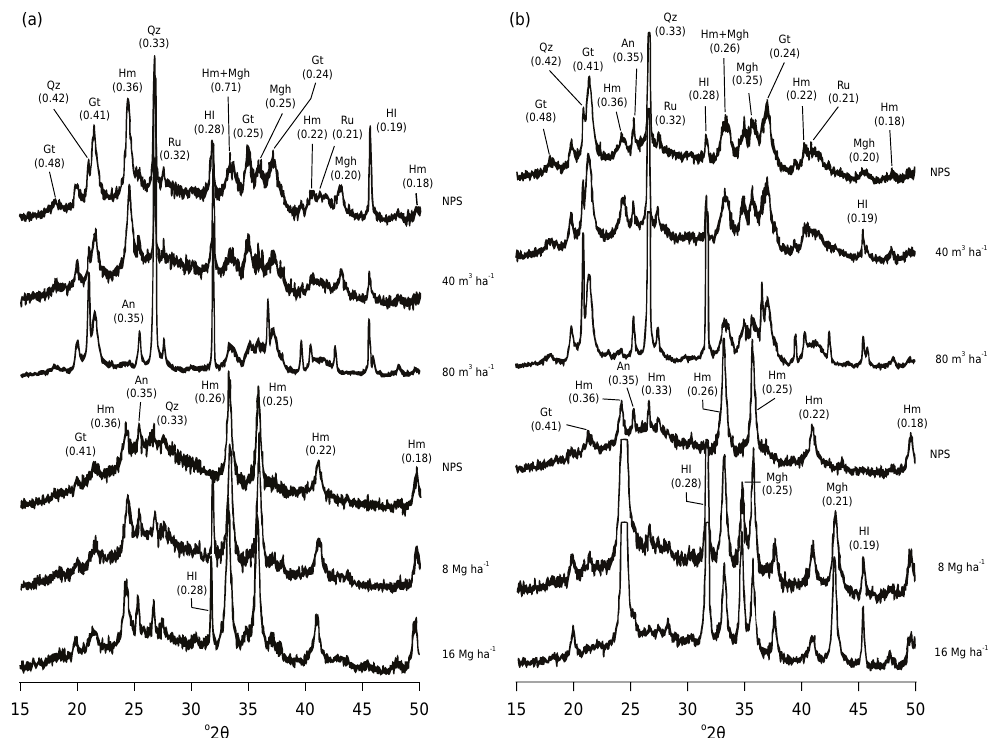
Figure 3. Clay fraction X-ray diffractograms of samples treated with NaOH of a Typic Rhodudalf (NPS, 40 m 3 ha -1 , and 80 m 3 ha -1 ) and of a Typic Hapludox (NCPS, 8 Mg ha -1 , and 16 Mg ha -1 ), from the 0.00-0.04 m layer (a) and 0.04-0.08 m (b); d spacing in mm. Kt = kaolinite; Gt = goethite; Qz = quartz; Hl = halite; Hm = hematite; Mgh = maghemite; Ru = rutile; An =